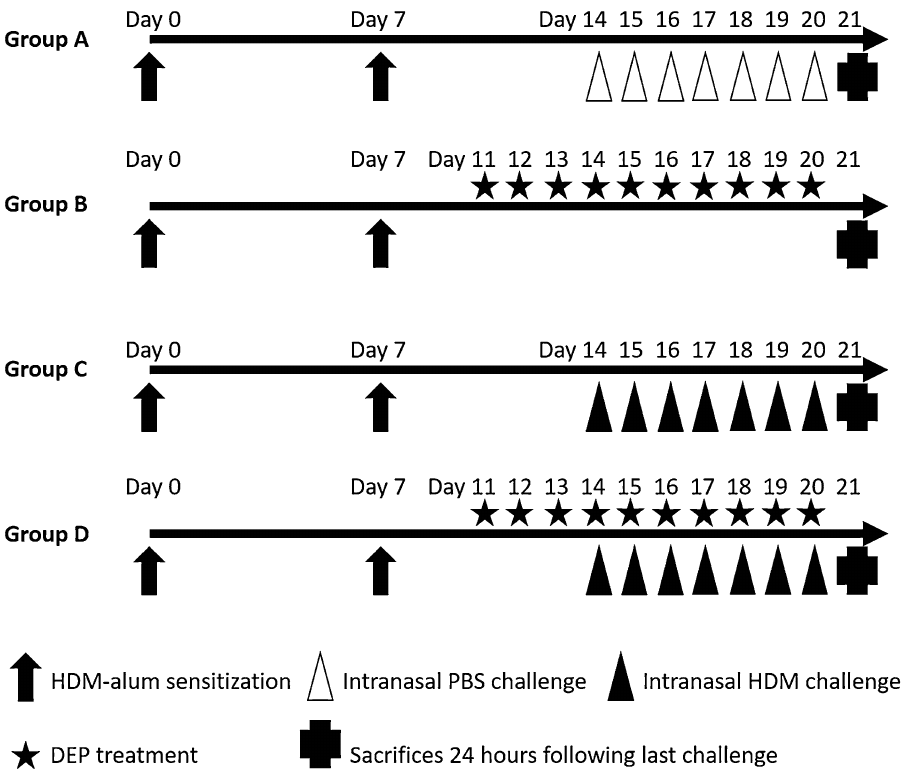
Figure 7. Experimental protocol. BALB/c mice were sensitized with intraperitoneal injection of HDM and alum on days 0 and 7. The mice in group A were intranasally challenged with PBS for seven consecutive days from day 14 to day 20. The mice exposed to DEP alone (group B) were treated with nasal instillation of DEP on days 11–20 without HDM. The mice in group C were intranasally challenged with HDM on days 14–20. The mice co-exposed to HDM and DEP (group D) were treated intranasally with DEP on days 11–20 and HDM on days 14–20 (2 h after administration of DEP). On day 20, the frequencies of nasal rubbing and sneezing behaviors were recorded for 15 min after the last intranasal challenge. Mice were sacrificed 24 h after the final